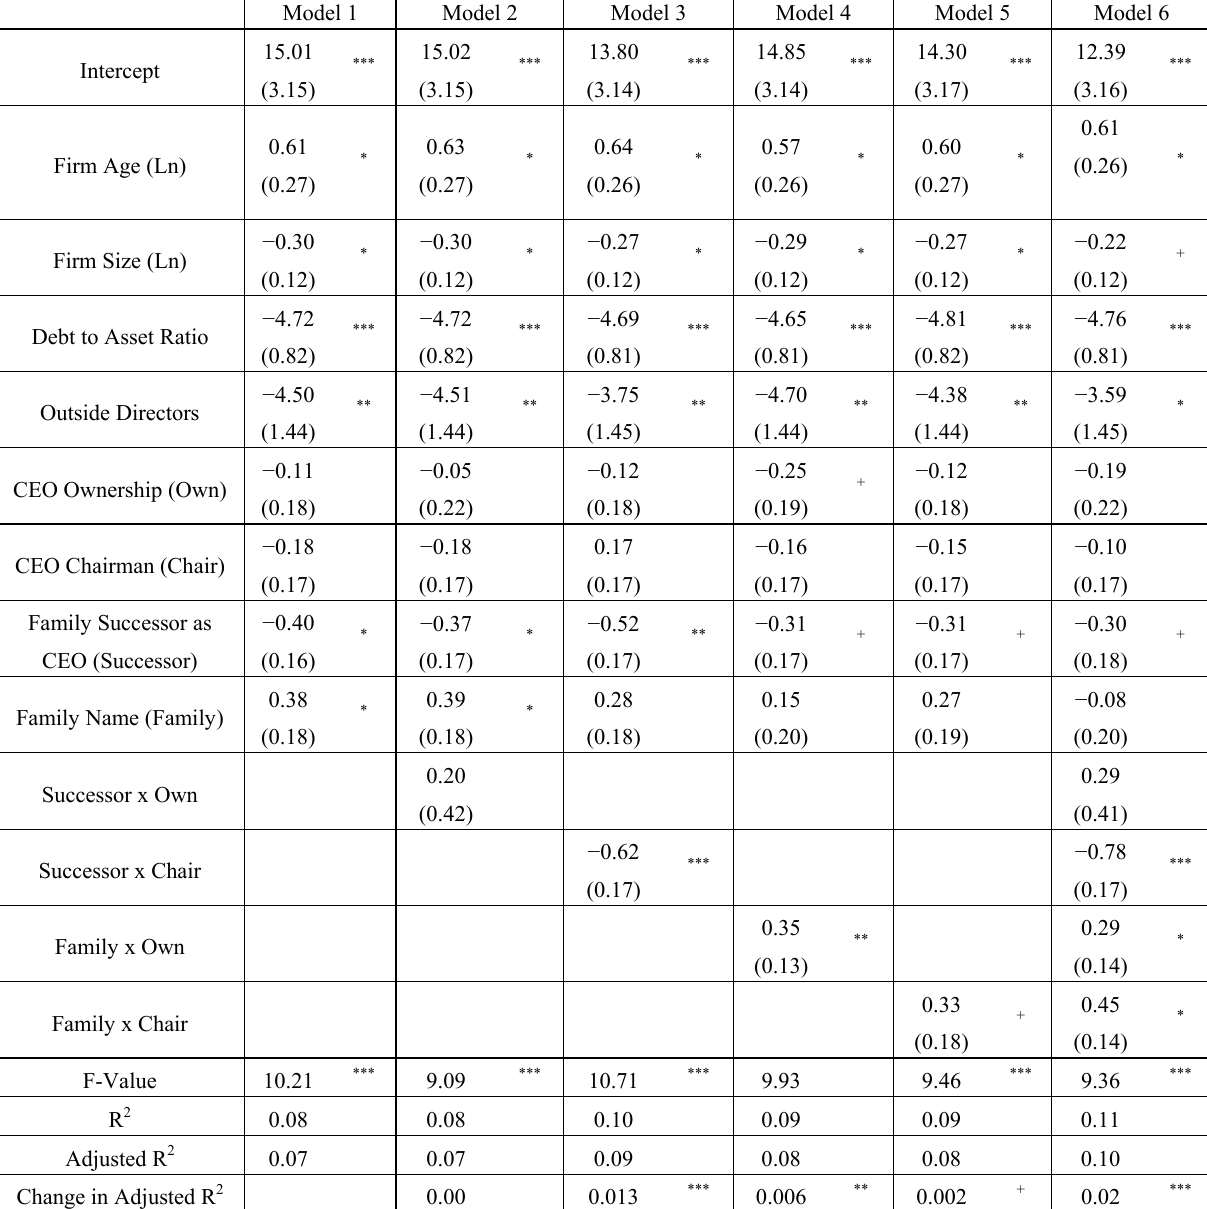
Table 6. Regression Results using Return on Assets as Dependent